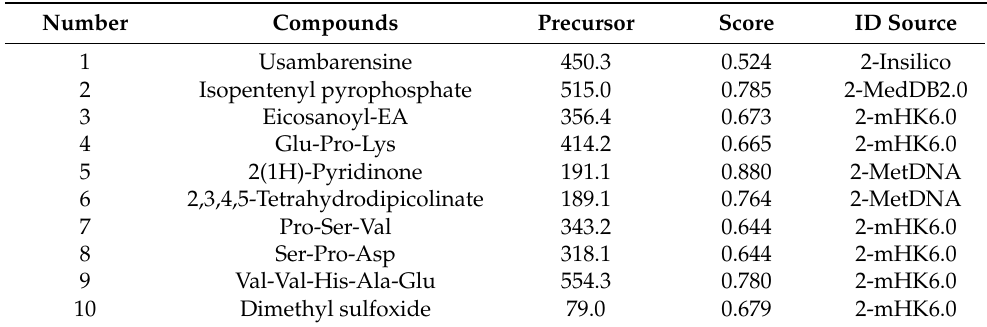
Table 3. Top ten compounds of the pink